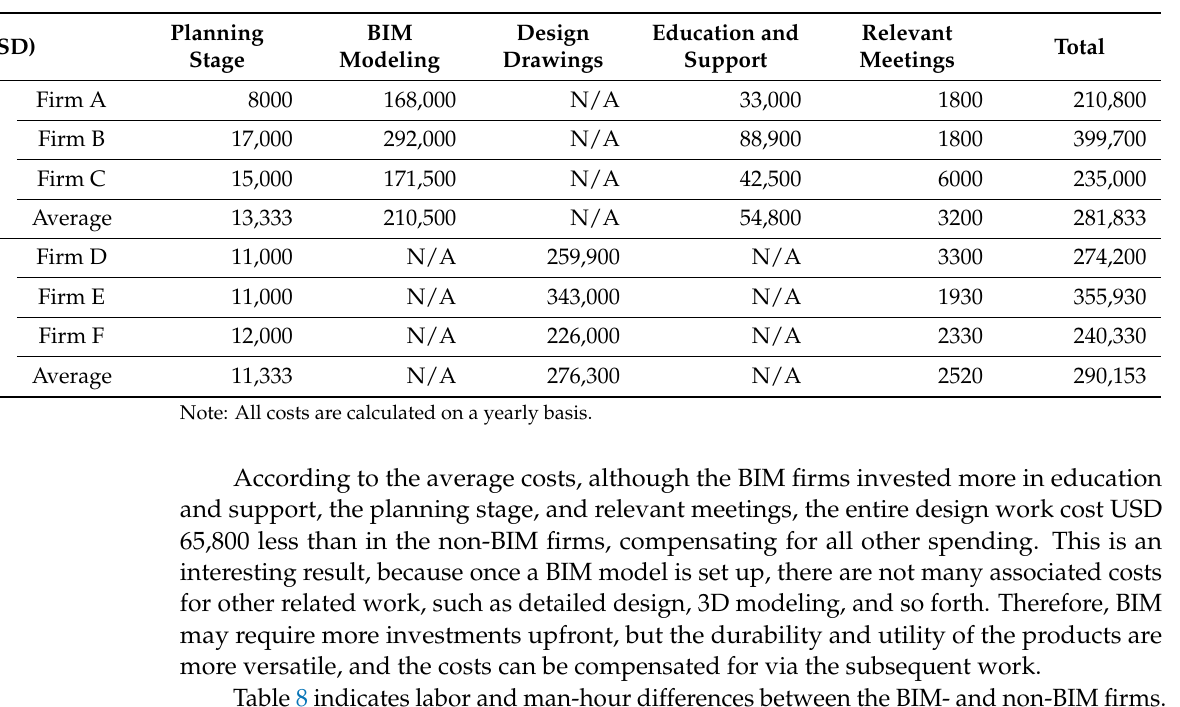
Table 7. Cost comparison between BIM and non-BIM